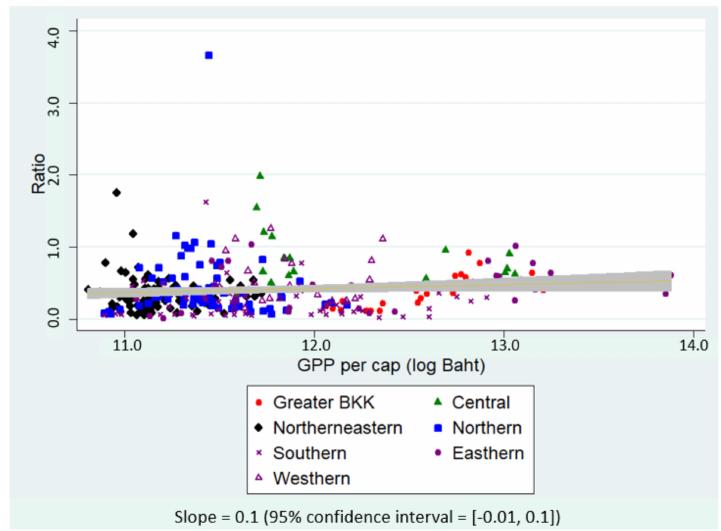
Figure 4. Scatter plot between the ratio of insured migrants to all migrants and GPP per capita, 2015–2018.